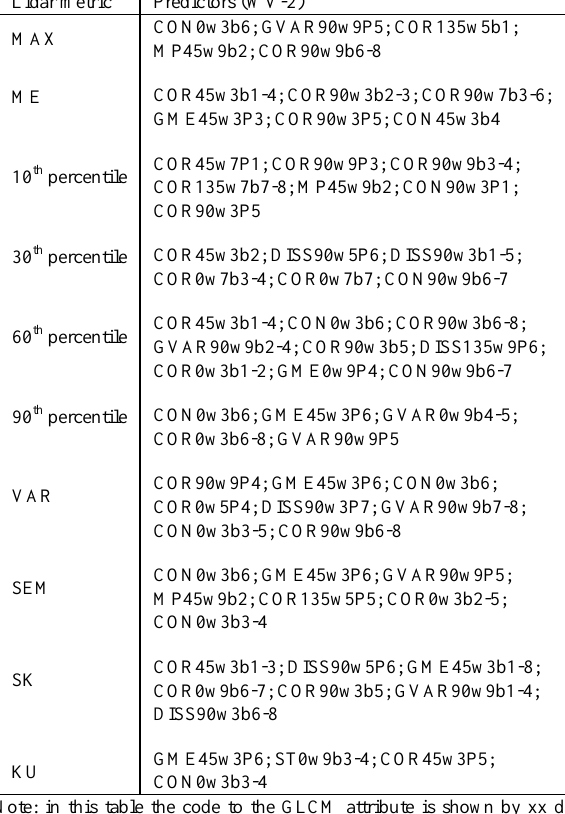
Table 2. Textural indices selected by the models developed for predicting each lidar